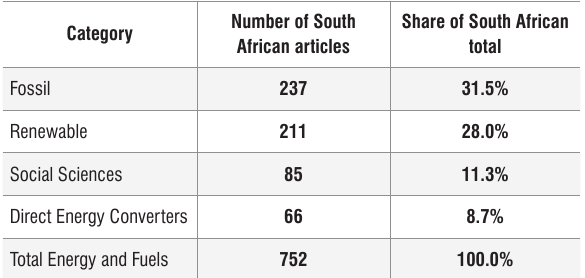
Classification into broad categories of Energy and Fuels articles